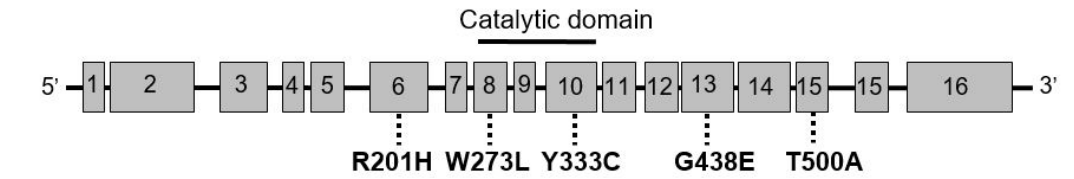
Figure 1. Structure of human GLB1 gene and Morquio B (MBD)-related mutations.